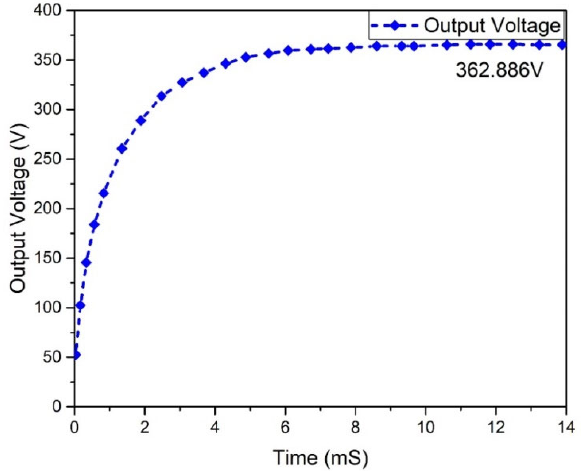
Figure 20. Output voltage of presented Flyback boost converter based (GaN-HEMT).